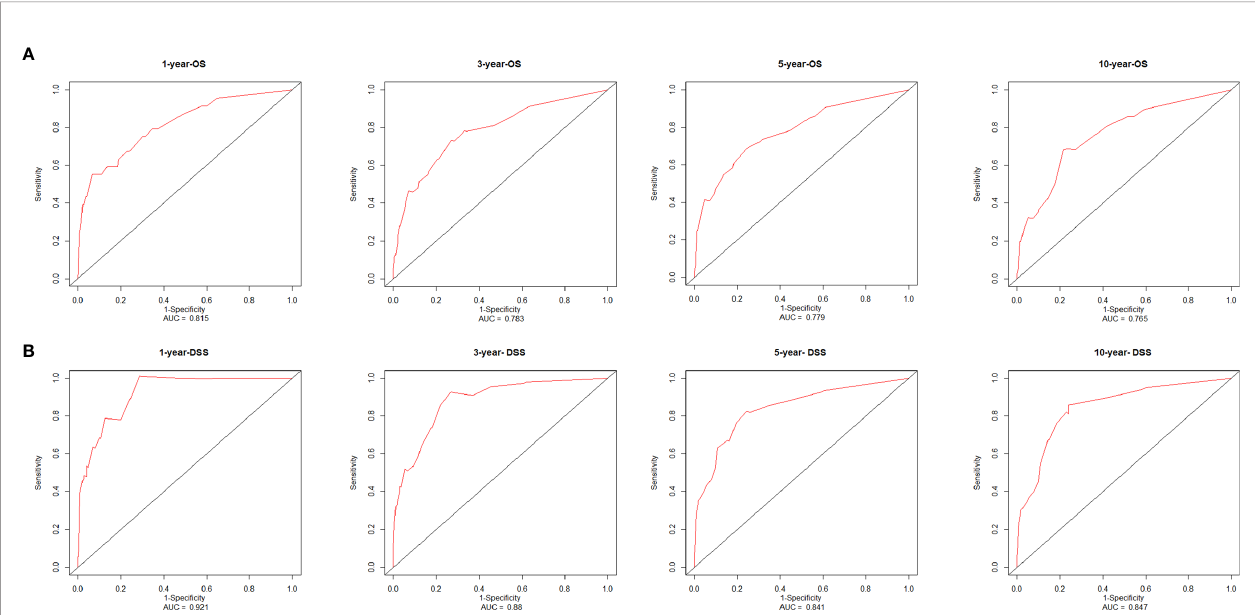
FIGURE 7 | Receiver operating characteristic curves and area under the curve values from the nomograms for 1-, 3-, 5-, and 10-year OS (A) and DSS (B) . AUC, area under the receiver operating characteristic curve; OS, overall survival; DSS, disease-speci fi c